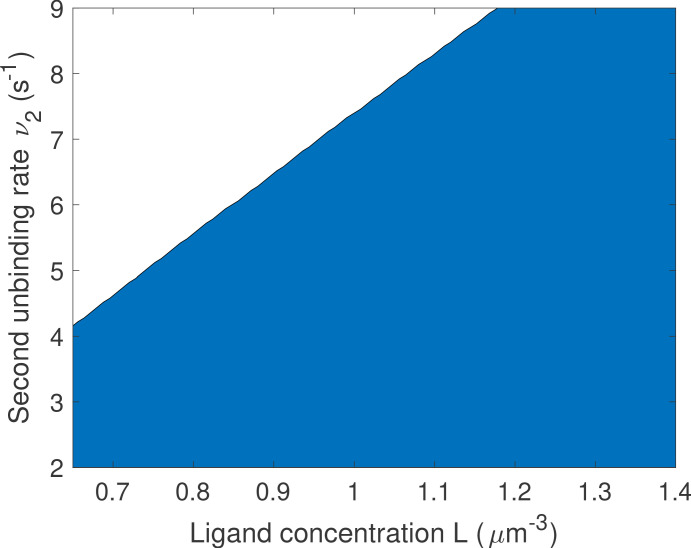
Changing the bounds of the rates does not change the qualitative results on the optimal number of binding sites.We proceed as in Main Text Figure 5f: for a given value of L and ν we compare one- and two-binding site architectures. The blue region corresponds to two binding site promoter being optimal and the white region to one binding site promoter being optimal. Parameters are the same as in Main Text Figure 5f except that the upper bounds for μ1 and μ2 are increased to 5⁢μ⁢m3⁢s-1 and that of ν1 is increased to 5.5⁢s-1. We find that the results are qualitatively similar to that of Main Text Figure 5f. although the transition to optimal one binding site region is shifted up.